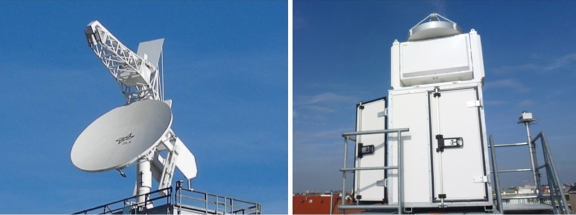
Figure 1. C-band POLDIRAD weather radar (left, photo: Martin Hagen) and Ka-band MIRA-35 cloud radar (right, photo: Bernhard